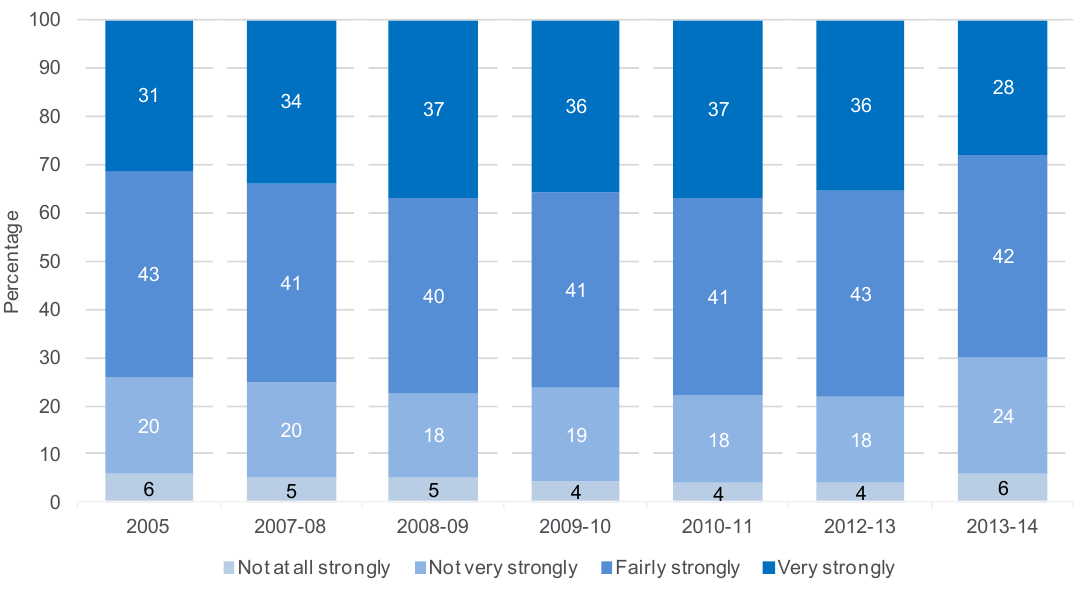
Figure 13: Proportion of people who feel they belong strongly to their neighbourhood, 2003 to